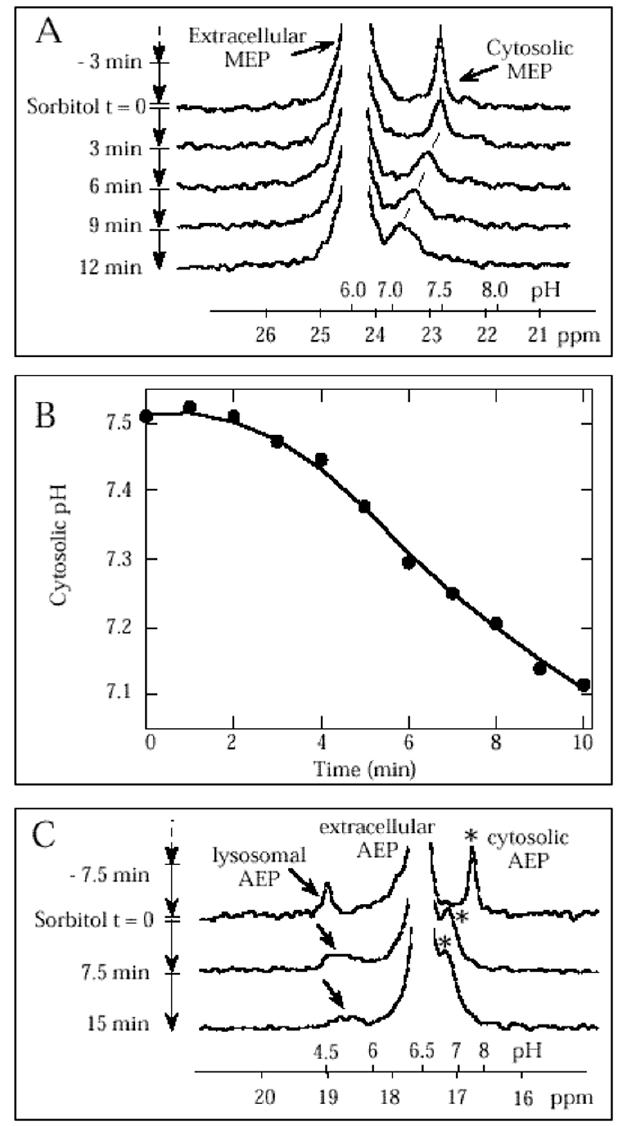
In vivo 31 P-NMR analysis of the effect of hyperosmotic shock on cytosolic pH in Dictyostelium cells (A) The sequence of 31 P-NMR spectra represents a typical experiment conducted with the probe MEP. After addition of MEP and pre- incubation during 60 min, a control spectrum was recorded for 3 min immediately before sorbitol addition (upper trace). Sorb- itol (0.3 M) was then added at T = 0 and data were collected during successive 3-min intervals up to 12 min. NMR spectra shown are the sum of 180 free induction decays with 1-s interpulse delays and correspond to a 3-min accumulation. Only the spectral region around +24 ppm corresponding to MEP probe is shown. The pH scale shown on abcissa was calculated from the in vivo calibration curve pH = 7.6 + log(24.5 - δ )/( δ - 20.6), 8 being the chemical shift of MEP resonance. (B) Temporal evo- lution of cytosolic pH after onset of hyperosmotic shock in Dictyostelium cells calculated from the position of cytosolic MEP resonance (see A). (C) In vivo 31 P-NMR analysis of the effect of hyperosmotic shock on lysosomal pH in Dictyostelium cells. The sequence of successive 31 P-NMR spectra represents a typical experiment conducted with the probe AEP. After addition of AEP and preincubation for 60 min, a control spectrum was recorded for 7.5 min immediately before sorbitol addition (upper trace). Sorbitol (0.3 M) was then added at T = 0 min and data were collected during two consecutive 7.5-min intervals. Only the spectral region around +18 ppm corresponding to AEP probe is shown. The pH scale indicated on the graph was calculated from the in vivo AEP calibration curve pH = 6.3 + log(19.1 - δ )/( δ - 16.5), δ being the chemical shift of AEP resonance. Lyso- somal and cytosolic AEP satellite peaks, lowfield and upfield of extracellular AEP, respectively, are indicated by arrow and star symbols,